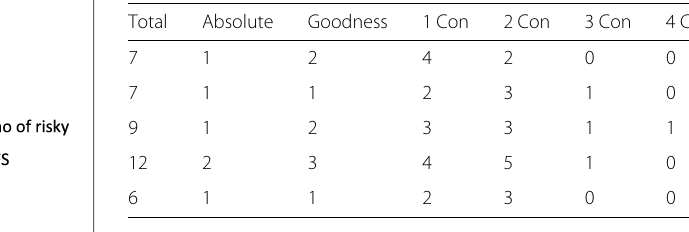
parameters). Functionalities here are constrained to 5 (Account, Analysis, Bank, Map, Scan) domains. As a whole total 11 domains are involved in the pool. Each of the functionalities has multiple queries to run on. Each query runs replaceability as proposed as well as accord- ing to replaceability measure discussed in [2]. Moreover, each query is also run for proposed equilibrium gaining algorithm and other two algorithms discussed in [19] and [17]. The details of the experiment on federation is given in Table 2.